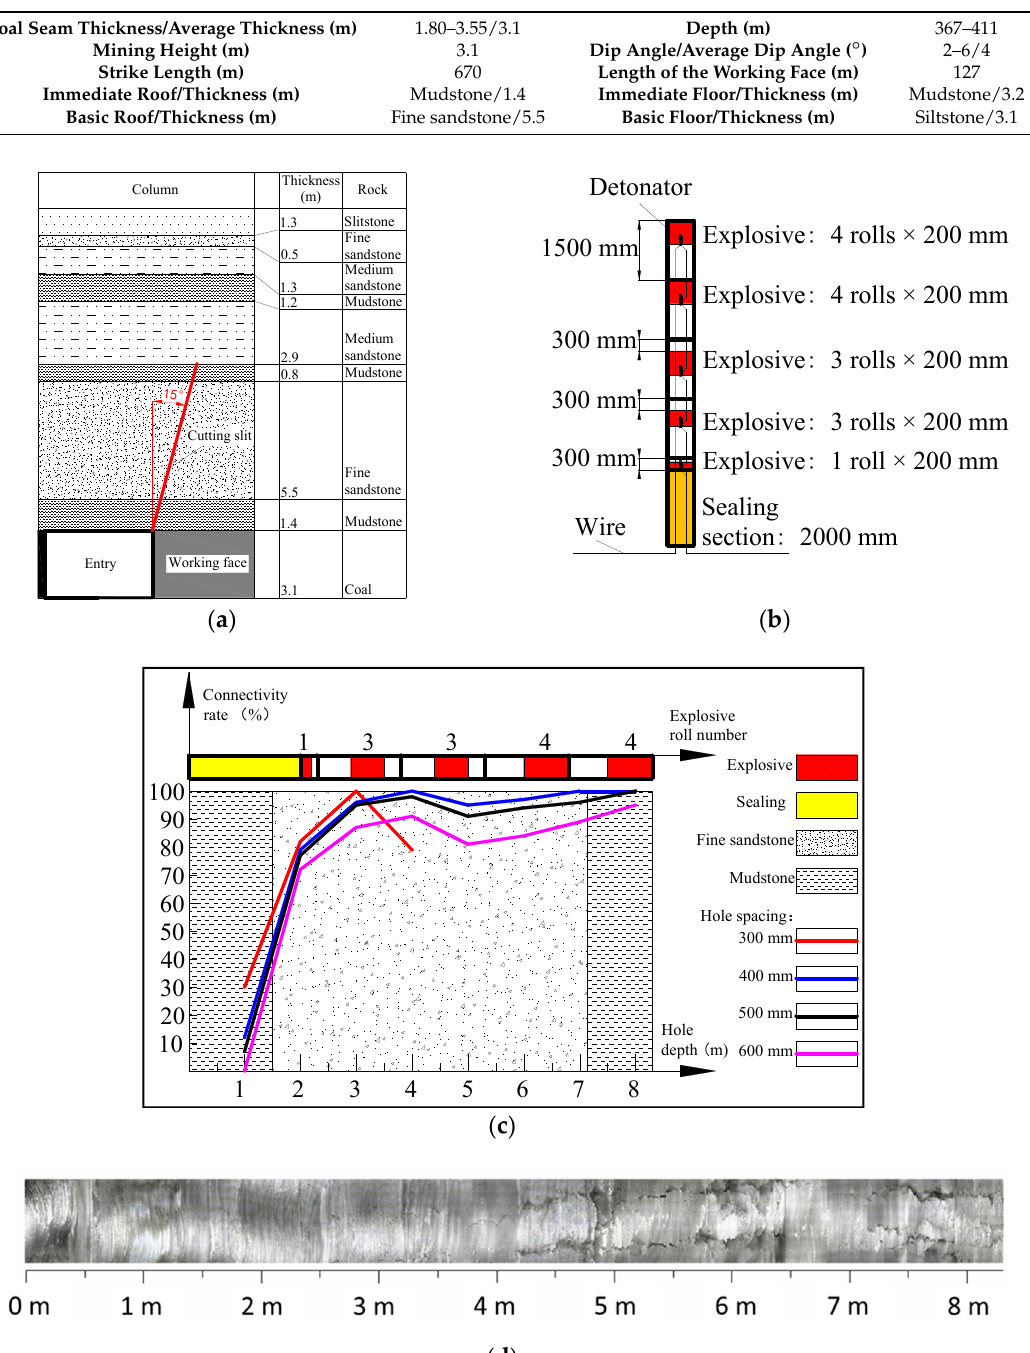
Figure 9. Roof cutting blasting design of the 8304 working face: ( a ) roof cutting design; ( b ) schematic of charge structure; ( c ) statistical drawing of roof cutting connectivity rate; ( d ) fissure diagram of the peep hole with 500 mm spacing.